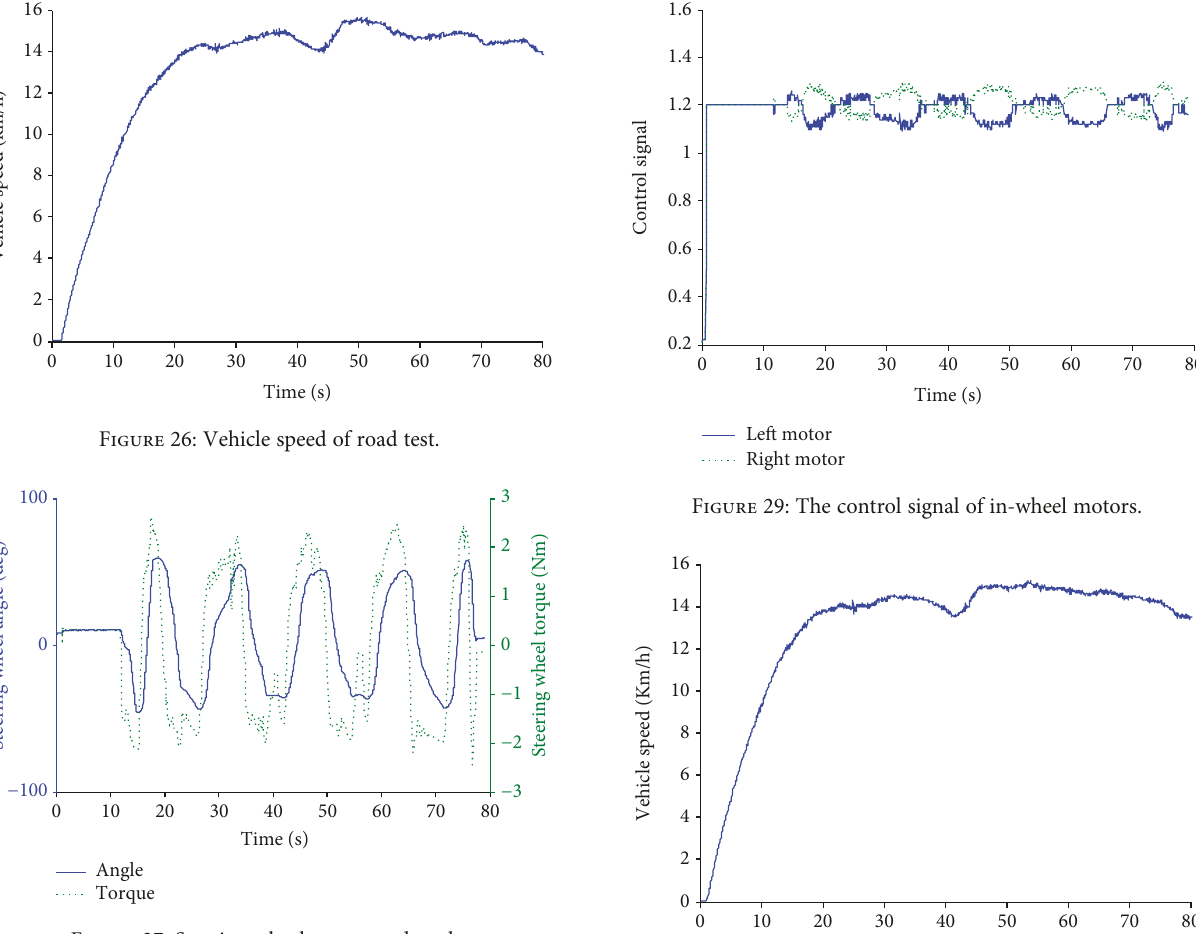
Figure 27: Steering wheel torque and angle.